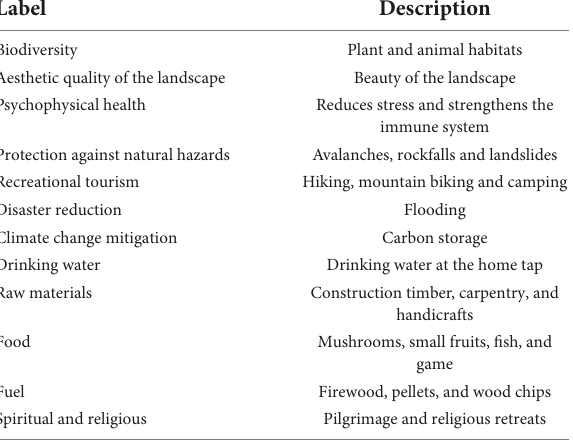
TABLE 1 Attributes list and description.